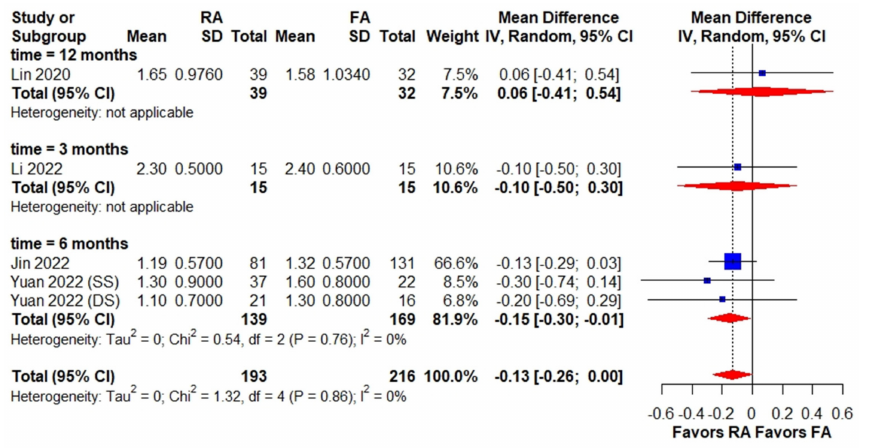
Figure 4. Forest plot of long-term VAS among patients receiving RA PKP versus FA PKP. The forest plot demonstrates long-term VAS among the RA PKP group versus the FA PKP group. The size of squares is proportional to the weight of each study. The result is summarized using weighted mean difference with corresponding 95% confidence interval (CI). Horizontal lines indicate the 95% CI of each study; red diamond indicates the pooled estimate with 95% CI. CI, confidence interval, FA PKP, fluoroscopy-assisted kyphoplasty, RA PKP, robot-assisted kyphoplasty, VAS, visual analog scale